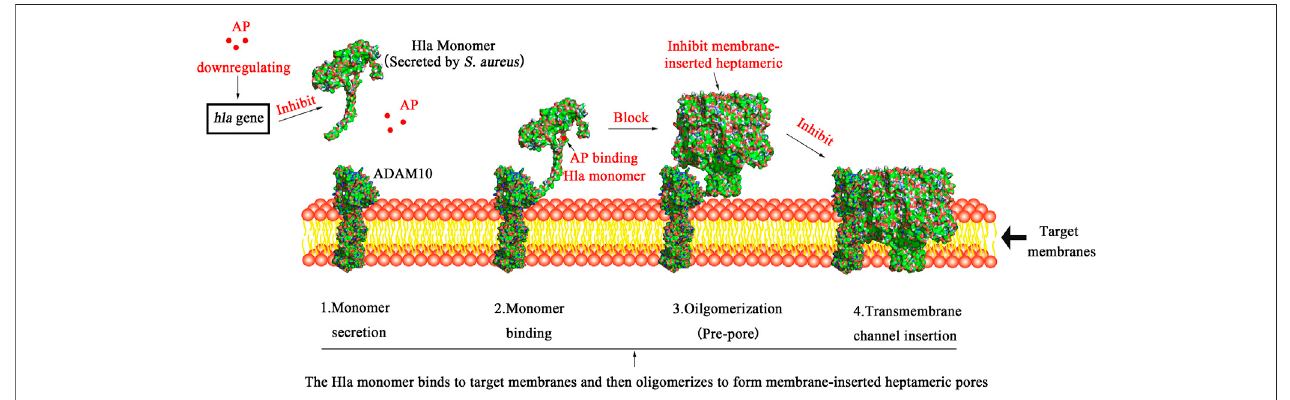
FIGURE 11 | Schematic diagram of the mechanism underlying AP inhibition of Hla. Note: 1. Hla is secreted as a water-soluble monomer; 2. Hla binds to the transmembraneproteinADAM10,whichisthecellularreceptorforHla;3.Hlathenoligomerizesintoheptamersontheplasmamembraneandformsaprepore;4.Finally, transmembrane channels are formed; AP can inhibit the transcription of S. aureus hla gene at the genetic level to suppress the expression of Hla protein. On the other hand, AP binding blocks the conformationaltransition from monomer to oligomer in the critical triangular region of the Hla monomer, thereby inhibiting the cell lysis activity of α